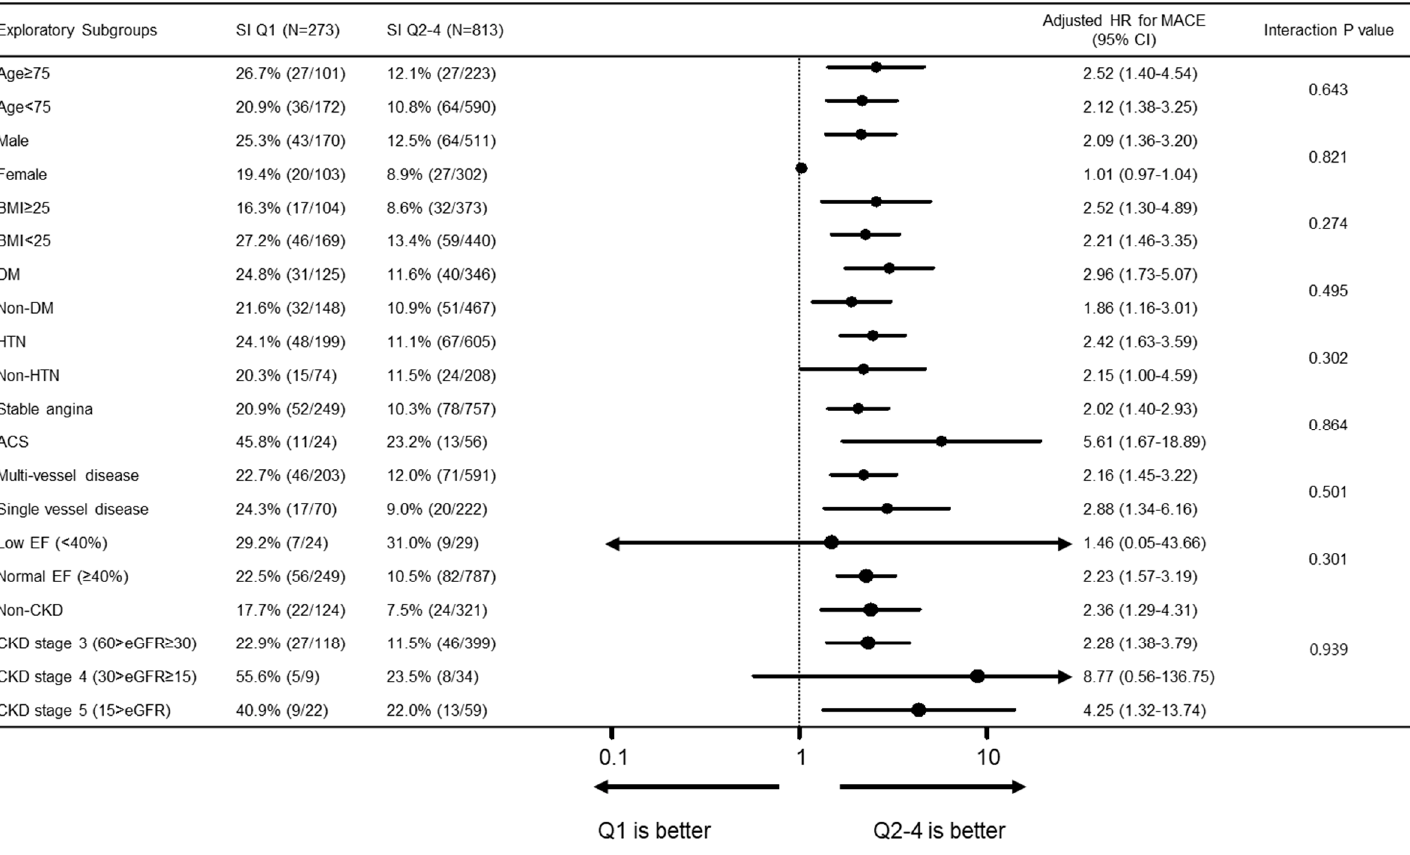
Figure 4. Subgroup analysis for MACE. In subgroup analysis, the poor prognosis of the Q1 group compared to that of the Q2–4 group was consistently observed across the various subgroups, without significant interaction. MACE = major adverse cardiovascular event; BMI = body mass index; DM = diabetes mellitus; HTN = hypertension; ACS = acute coronary syndrome; EF = ejection fraction. The following patient risk factors were included in the multivariate-adjusted Cox proportional hazard regression model: age, sex, body mass index, diabetes mellitus, hypertension, peripheral vascular disease, previous myocardial infarction (MI) or PCI, current smoking, previous congestive heart failure, clinical diagnosis, low EF, diseased vessel extent and total stent length.